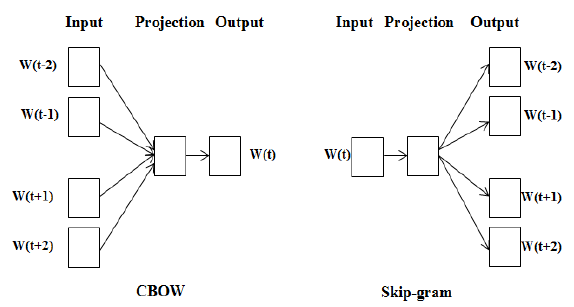
Fig 2 . CBOW and Skip-Gram model [8]